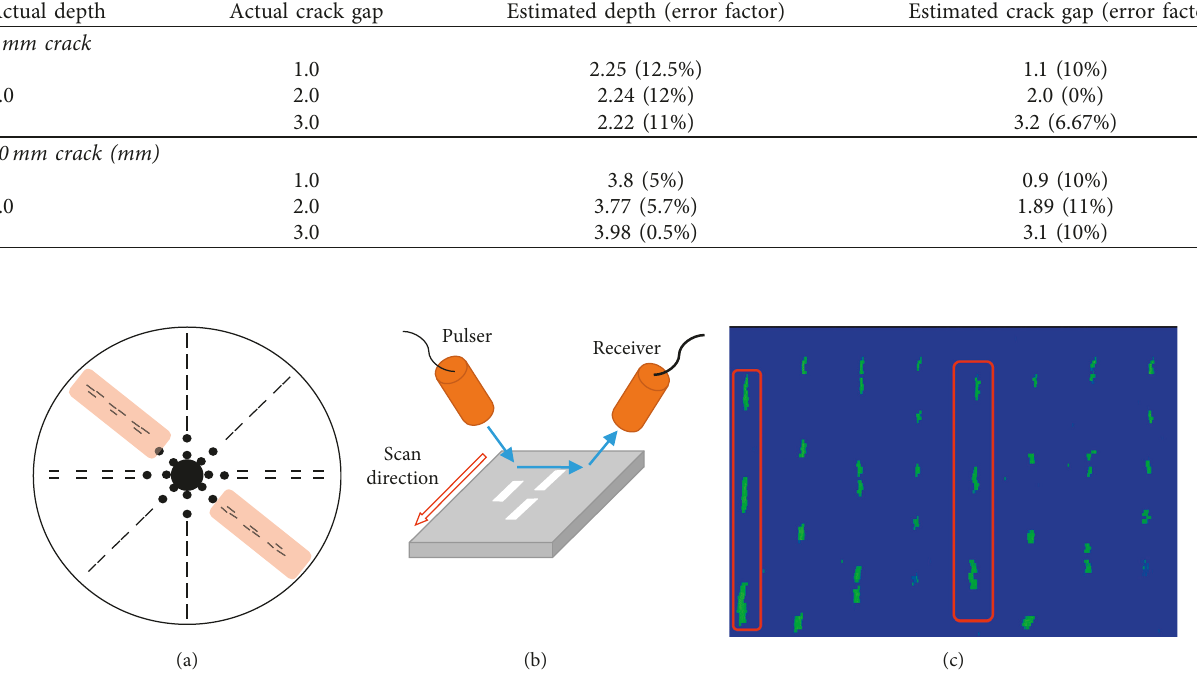
Figure 21: Experiment setup of triple-type crack: (a) crack location, (b) experiment method, and (c) C-scan image.